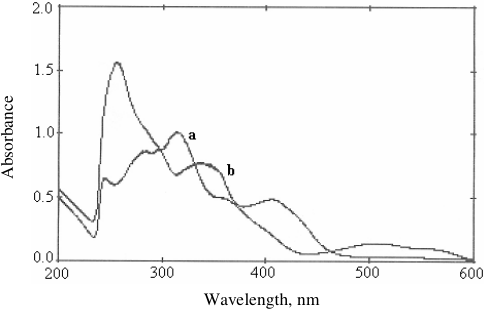
Figure 1. Zero-order spectra of (a) Cu-NDTT complex and (b) Ni-NDTT complex